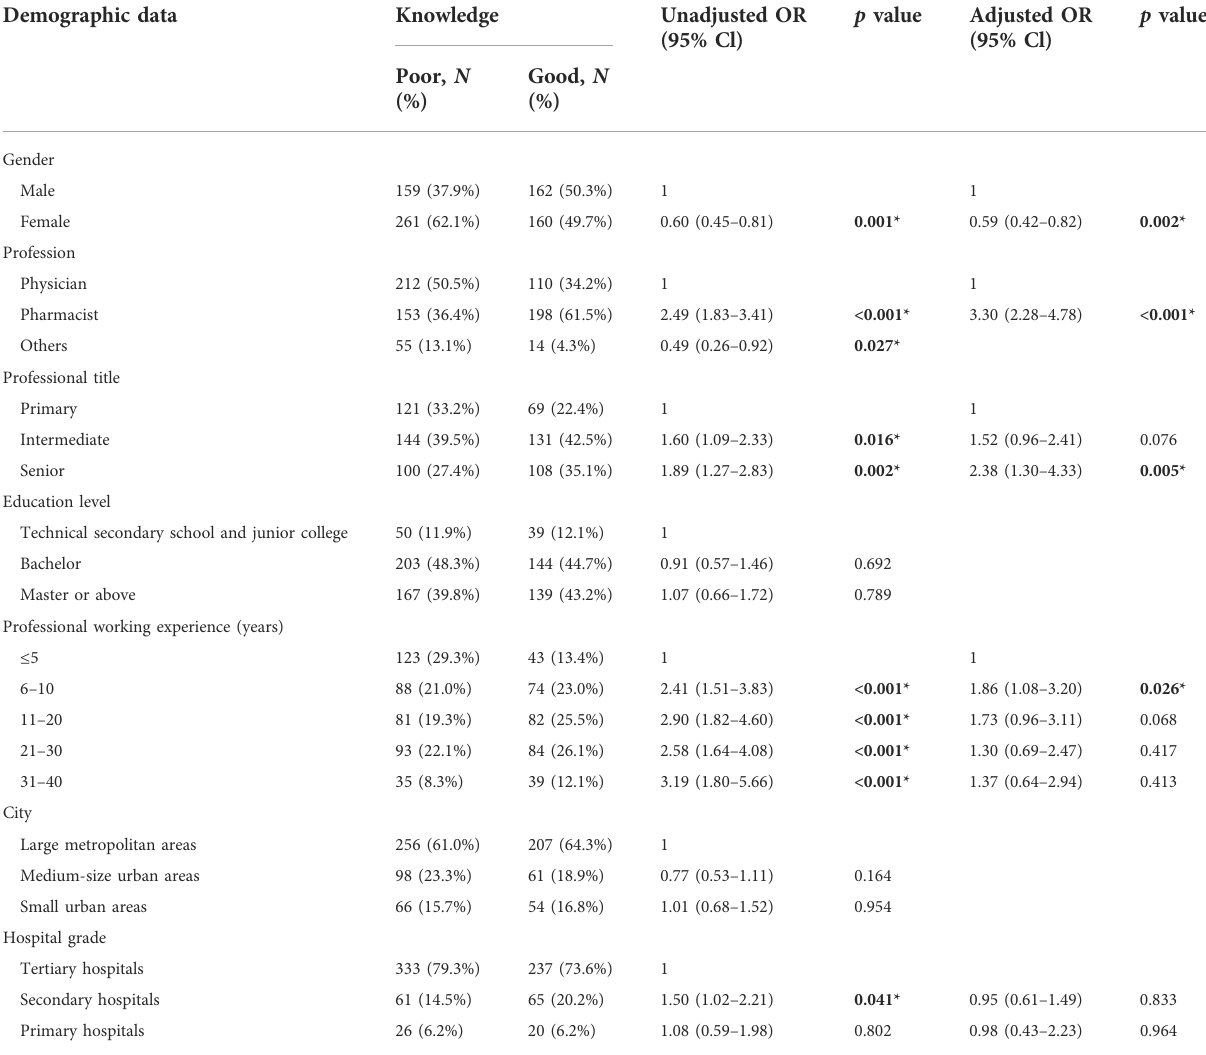
TABLE 2 Univariable and multivariable analysis of associated factors of HCPs ’ knowledge towards NCDP